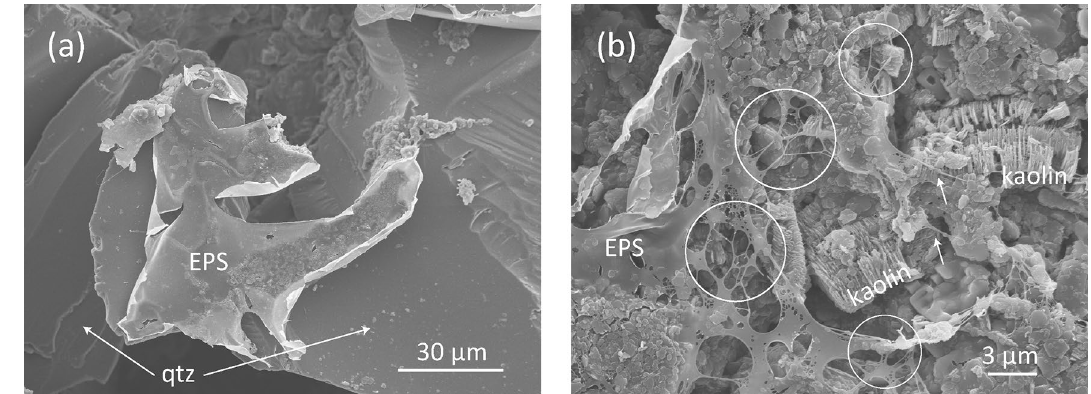
Figure 5. SEM images of dried samples (K40Q60_0.31 Φ _0.5% gum). ( a ) Xanthan gum film physically bonded to quartz grains. Circles in ( b ) indicate typical fibrous textures of xanthan gum. Abbreviation: qtz =